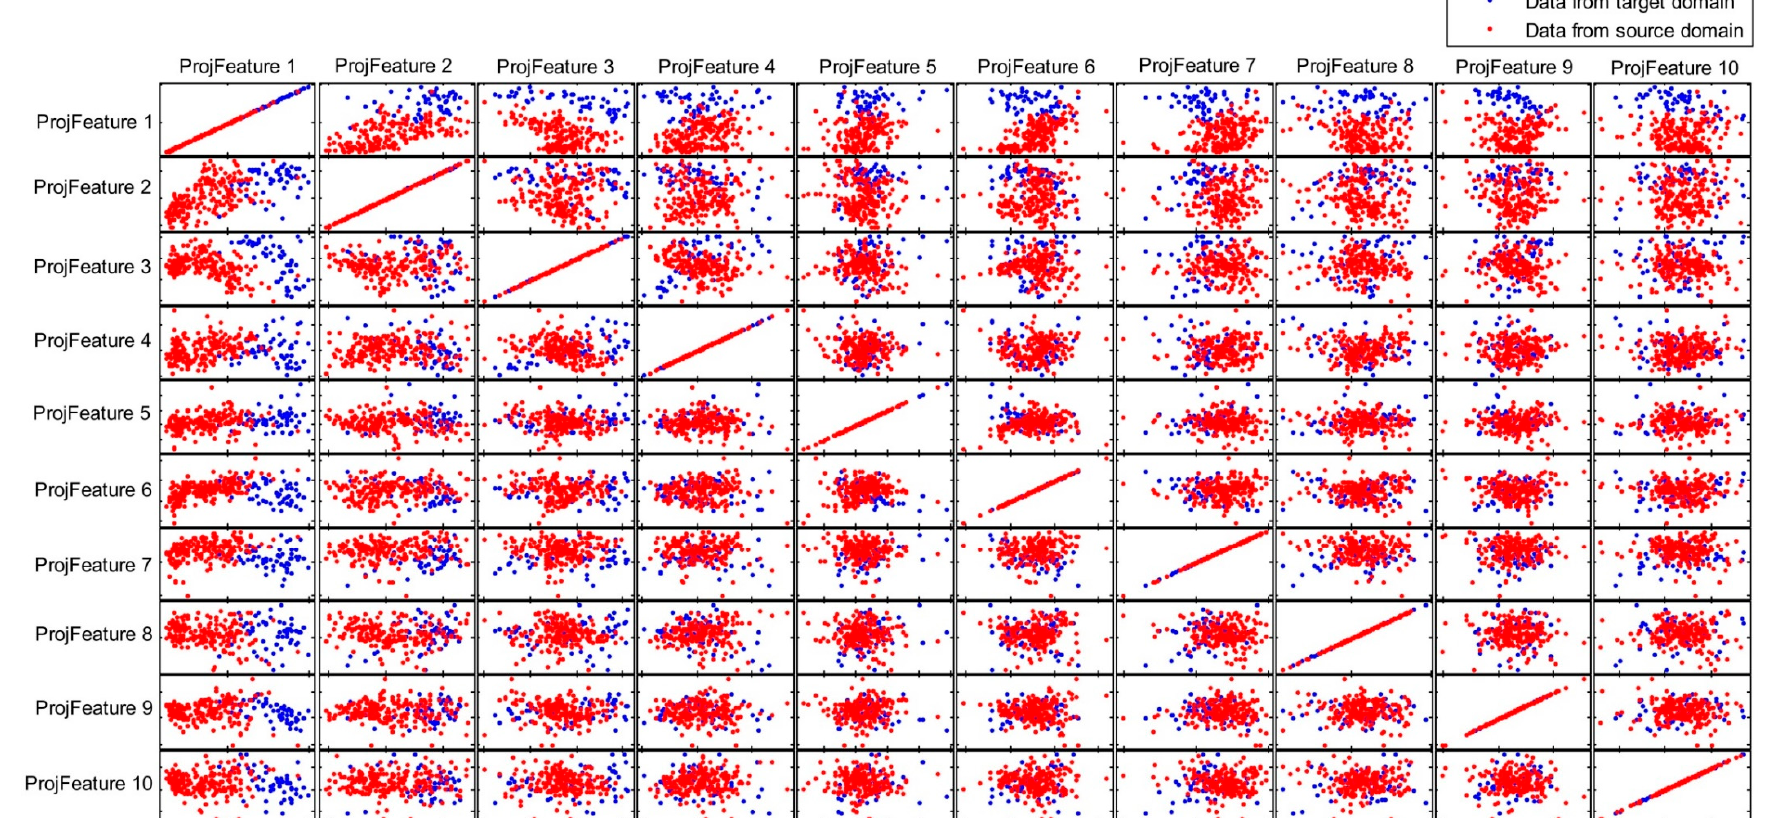
Figure 5. The scatter plot matrix of projected feature spaces over Bear Fire. Each panel is one scatter plot of a pair of projected features. Blue dots are field survey data from the target domain area: Bear Fire (n = 55). Red dots are field survey data from source domain areas: Jasper, Mule, and PW03-Wolf Fires (n = 199). Note that the distributions of data from target domain area and source domain areas are similar in most projected feature spaces.